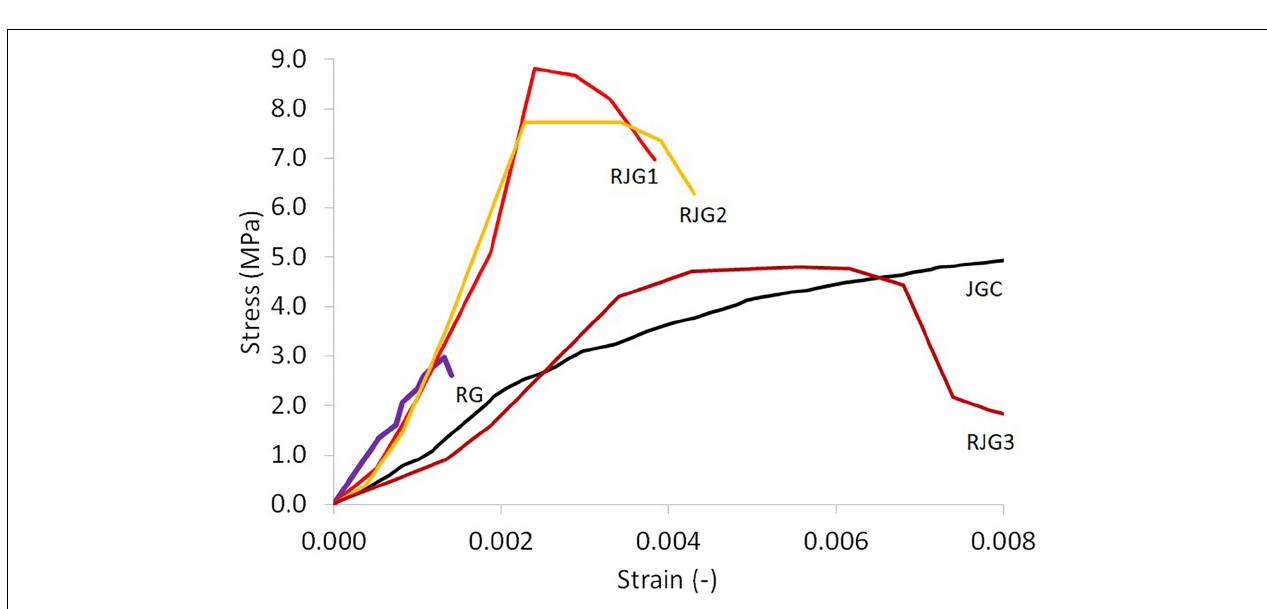
FIGURE 11 | Stress–strain curves of reference geopolymer (RG), jute-reinforced geopolymer composite (JGC) and recycled jute-reinforced geopolymer composites (RJG1, RJG2, and RJG3).